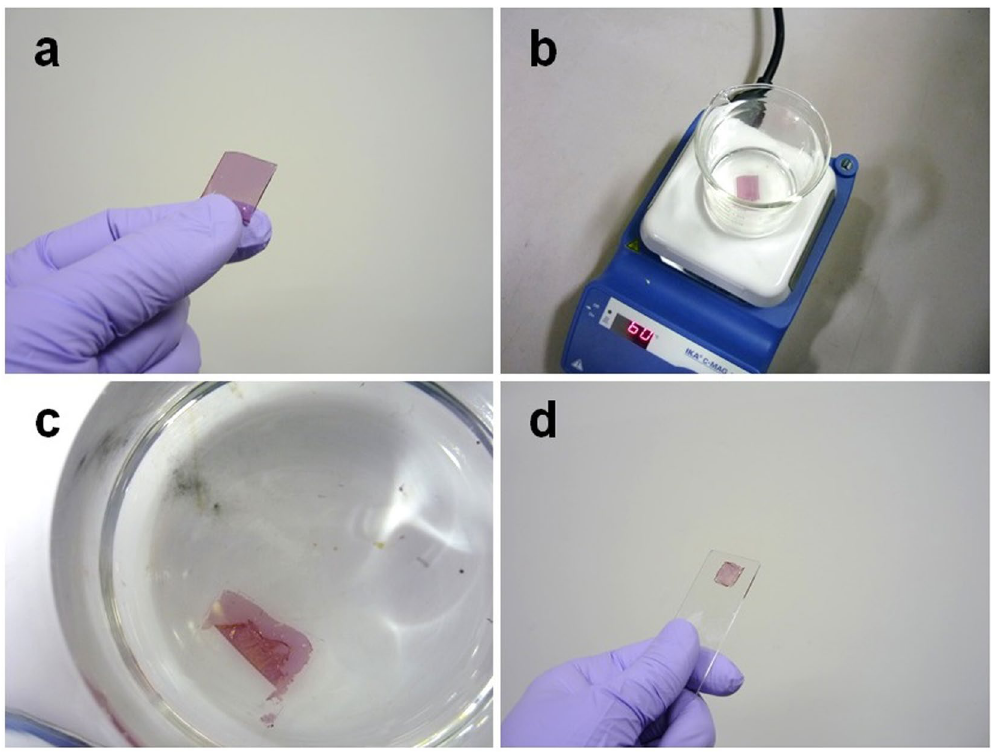
Figure 2. Photographs of uniaxial aligned 40 nm thick P3HT film picked up from a substrate. ( a ) P3HT film prepared using the soft friction transfer method on an ITO-coated glass substrate. ( b ) The film is immersed in water, ( c ) peeled from the substrate, and ( d ) then transferred to a glass slide as another